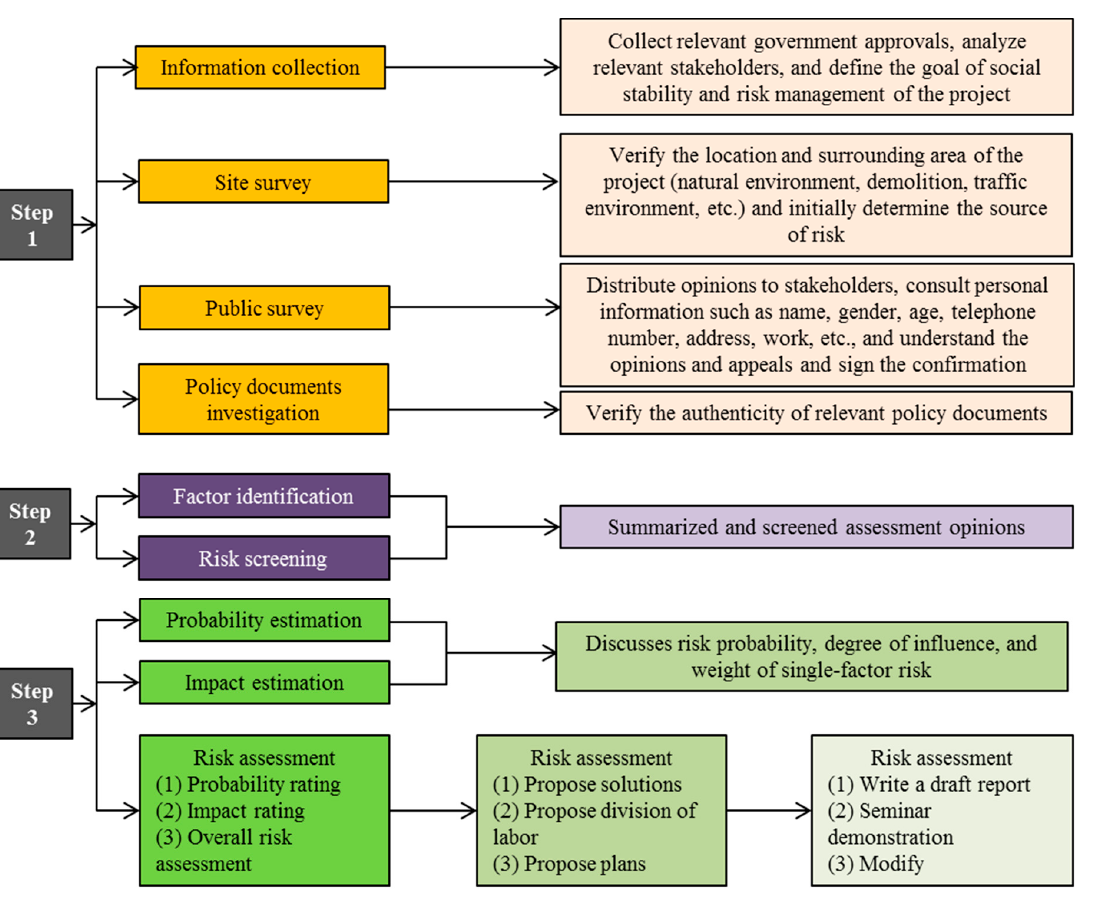
Figure 2. Framework of social risk management for land expropriation.